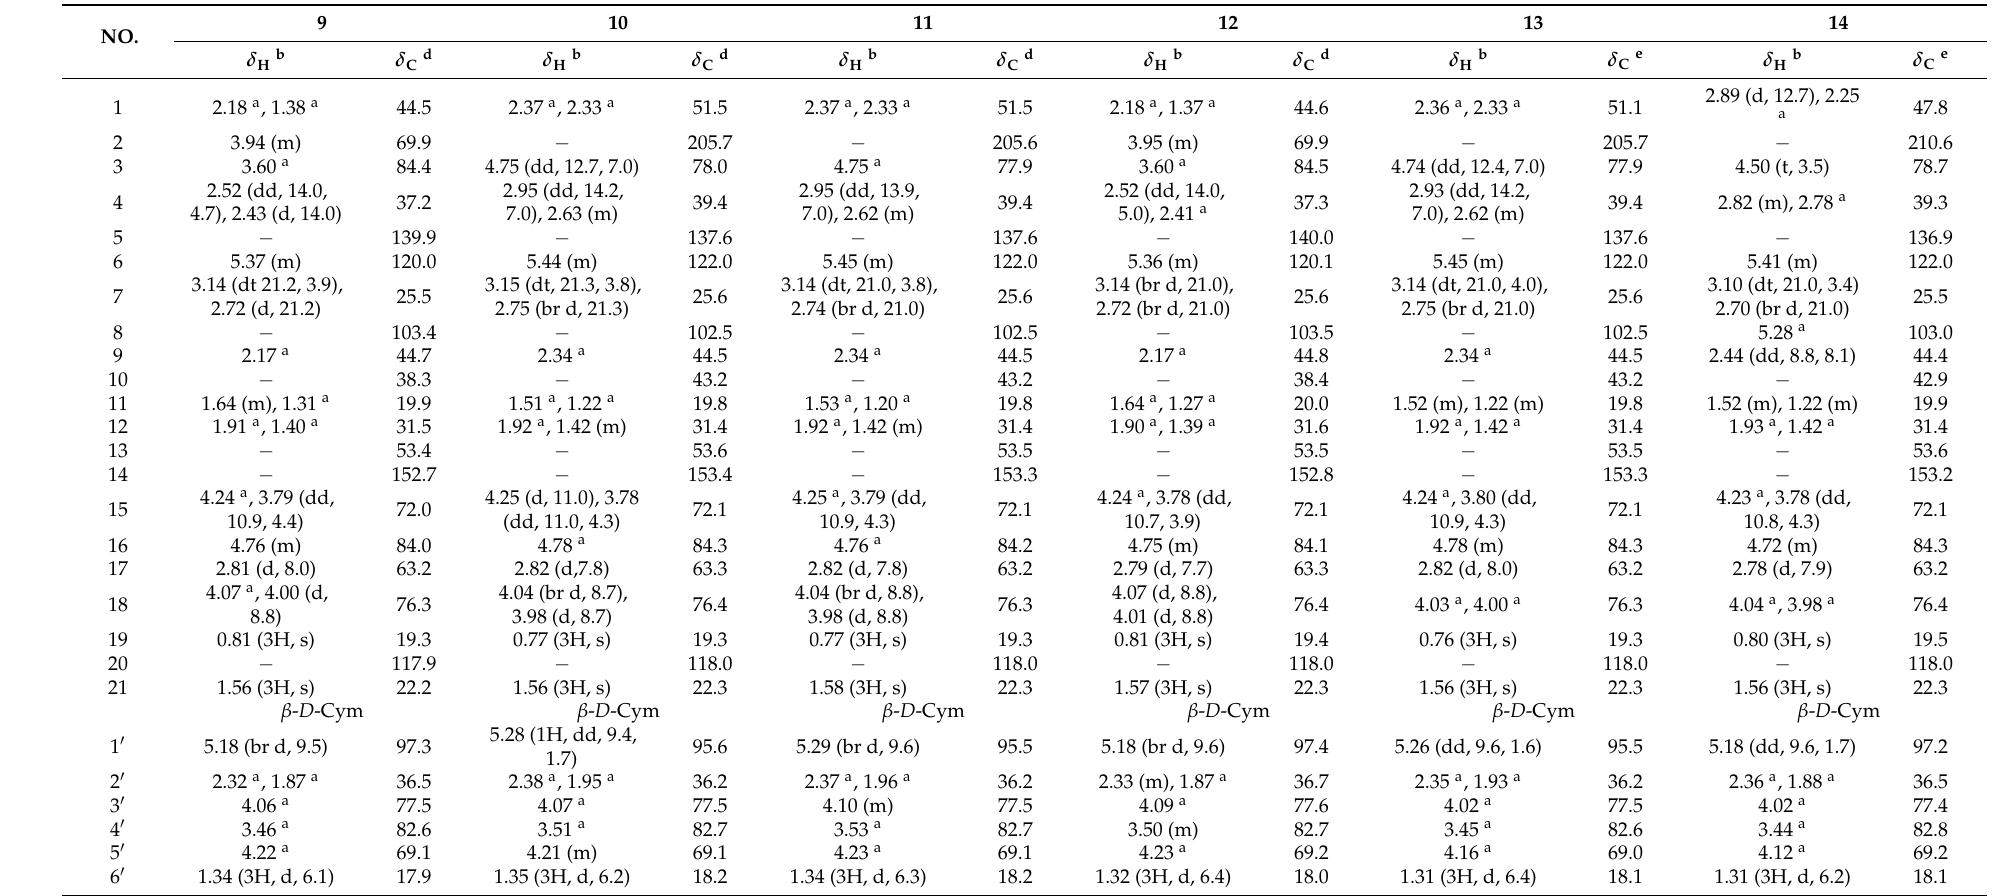
Table 2. 1 H and 13 C NMR data in C 5 D 5 N for compounds 9 – 14